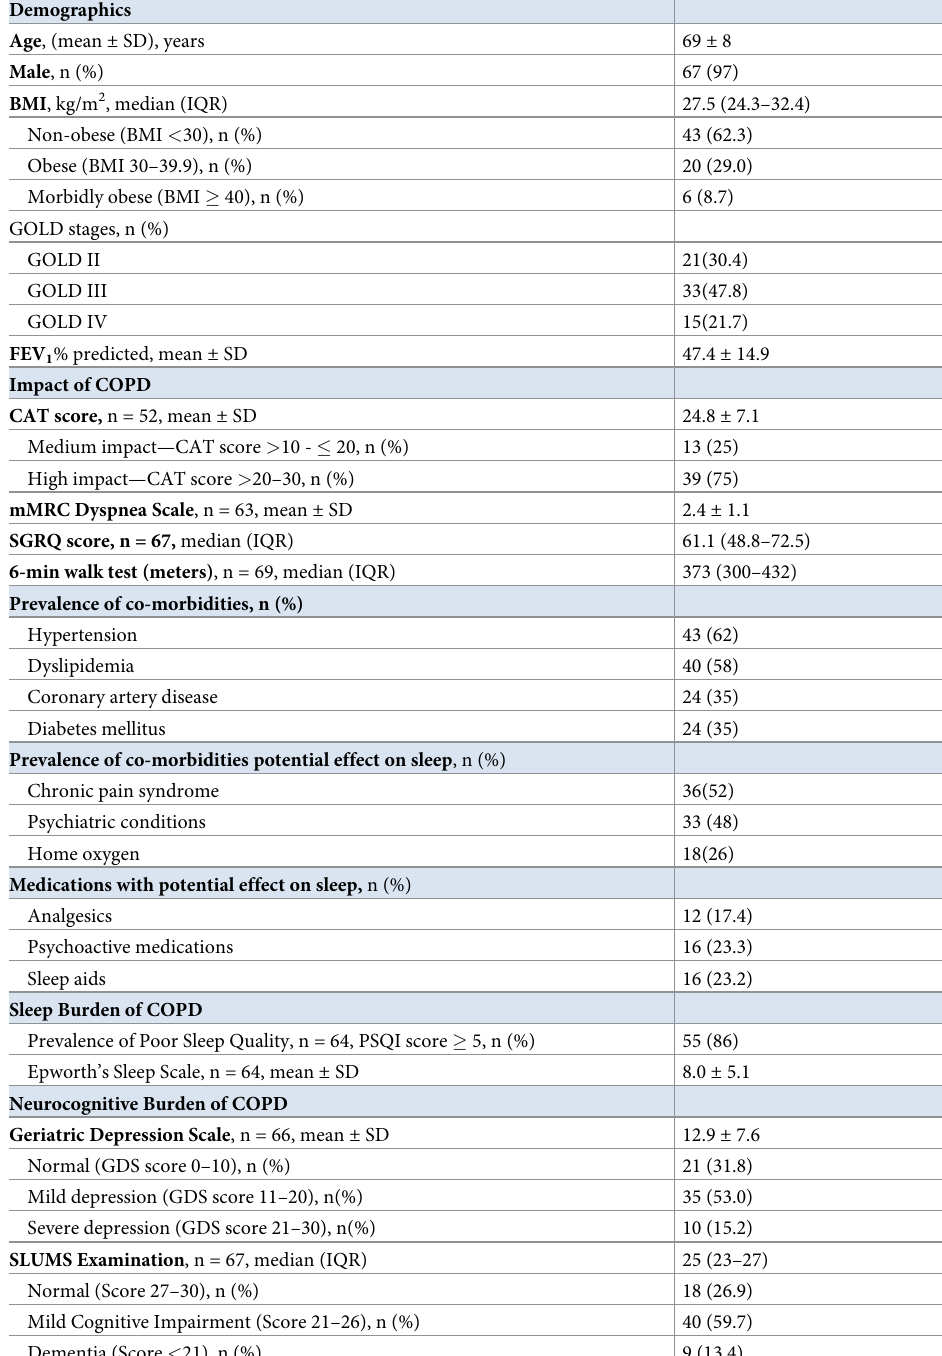
Table 1. Baseline characteristics of the study